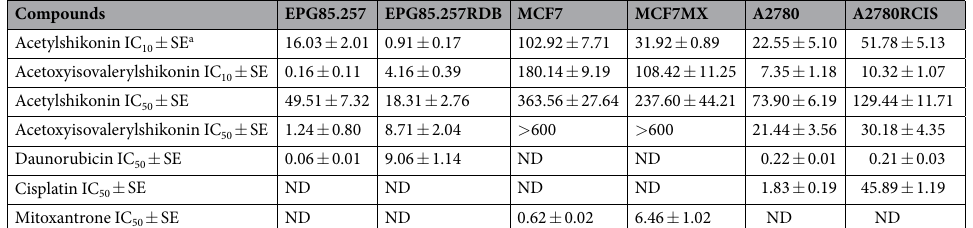
Table 1. IC 10 and IC 50 values for shikonin derivatives and standard chemotherapeutics agents on the cancer cells. a Drug concentration ( µ M) necessary for 10% or 50% inhibition of cell growth after 5 days of drug treatment. Data display the mean ± standard error of three distinct experiments. The extrapolated IC 50 values for acetoxyisovalerylshikonin for MCF7 and MCF7MX cells are 991 and 819 μ M, respectively. ND, not